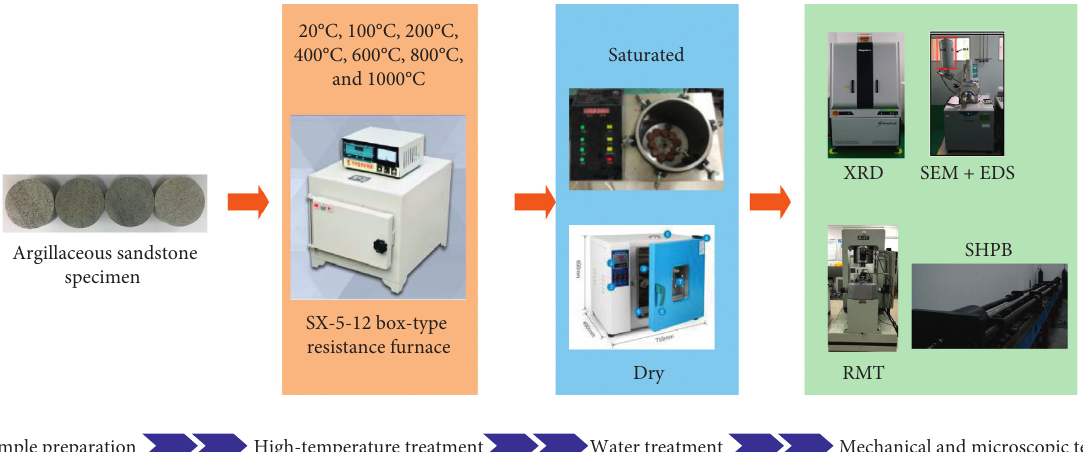
Figure 3: Experiment device and test procedures.